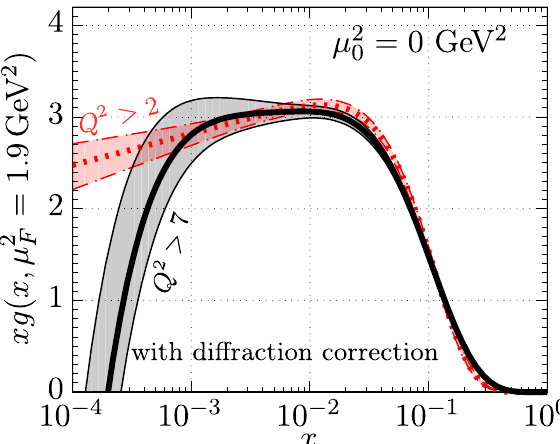
Fig. 7 Gluon distributions obtained from fits using (full) diffraction corrections and with a parameterization with the final (negative) term in (5). There is a large instability for x < 10 − 3 depending on whether the DIS data in the region 2 < Q 2 < 7GeV 2 is included or not Here we focus on the gluon, since at low- x it is the most the same behaviour as that for gluons. The x dependence of xg is shown in Fig. 4 at a low scale μ 2 = 1 . 9 GeV 2 which can be viewed as the input scale. The plot contains three pairs of curves. The lower pair of curves are the